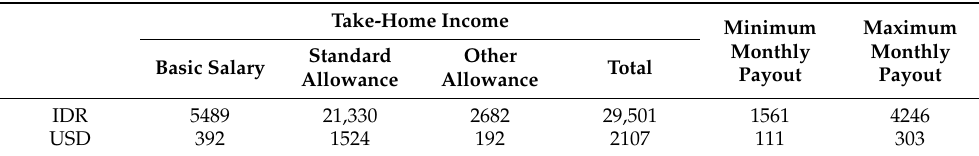
Table 1. Take-home income and monthly retirement payout of director, IV/d existing system, 2020 ( in thousand IDR ).